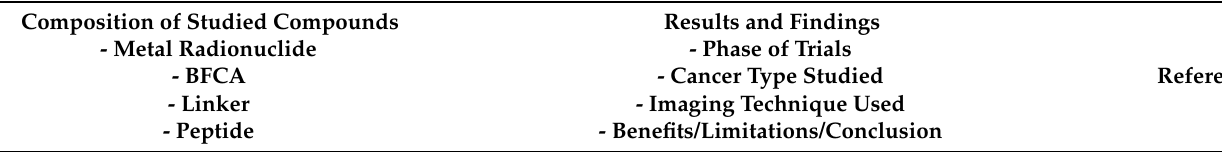
Table 12. Summary of radiolabeled NT, α -MSH, substance P, and VIP analogues for other important receptor-positive tumor imaging over past 3